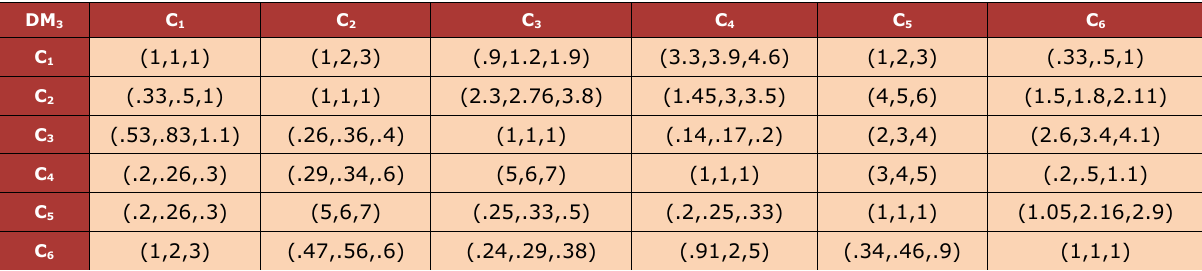
Table 4. Pair-wise comparison of third decision